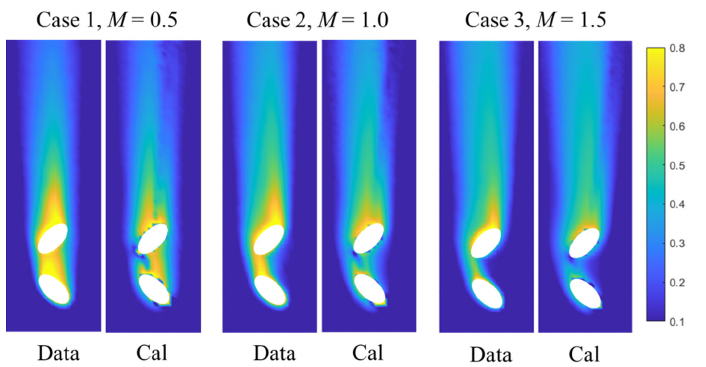
Figure 5. Comparison of film cooling effectiveness contours between the data and calculation at different M .